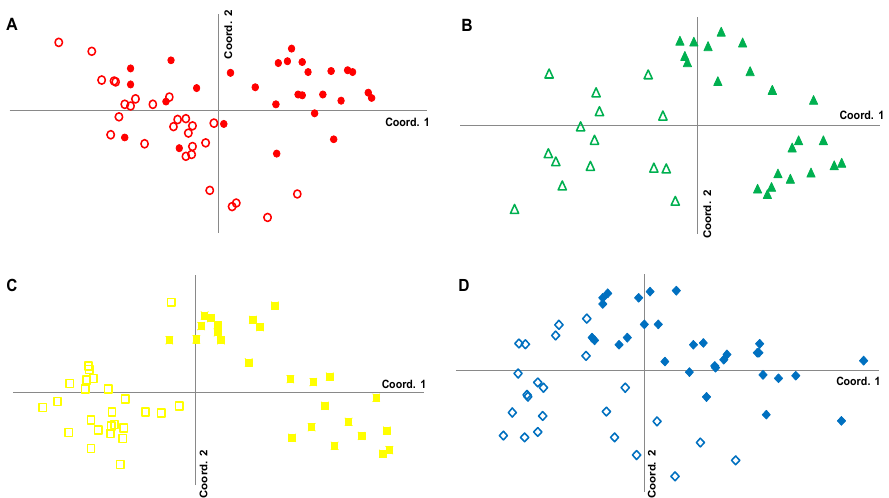
Figure 4. Principal coordinate analysis (PC O A) for the red mangrove, Rhizophora mangle , at each hydrological system within the Transverse Coastal Corridor, southern Quintana Roo, Mexico, using ISSR molecular markers. Chetumal Bay ( A ): Tamalcab (solid circle) and Playa Cayo Venado (empty circle), Bacalar Lagoon ( B ): Pedro Santo (solid triangle) and Huub’ Sak (empty triangle), Hondo River ( C ): entrance (solid square) and inward (empty square), and Caribbean Coast ( D ): Bacalar Chico (solid rhomb) and Xcalak National Reef Park (empty rhomb).